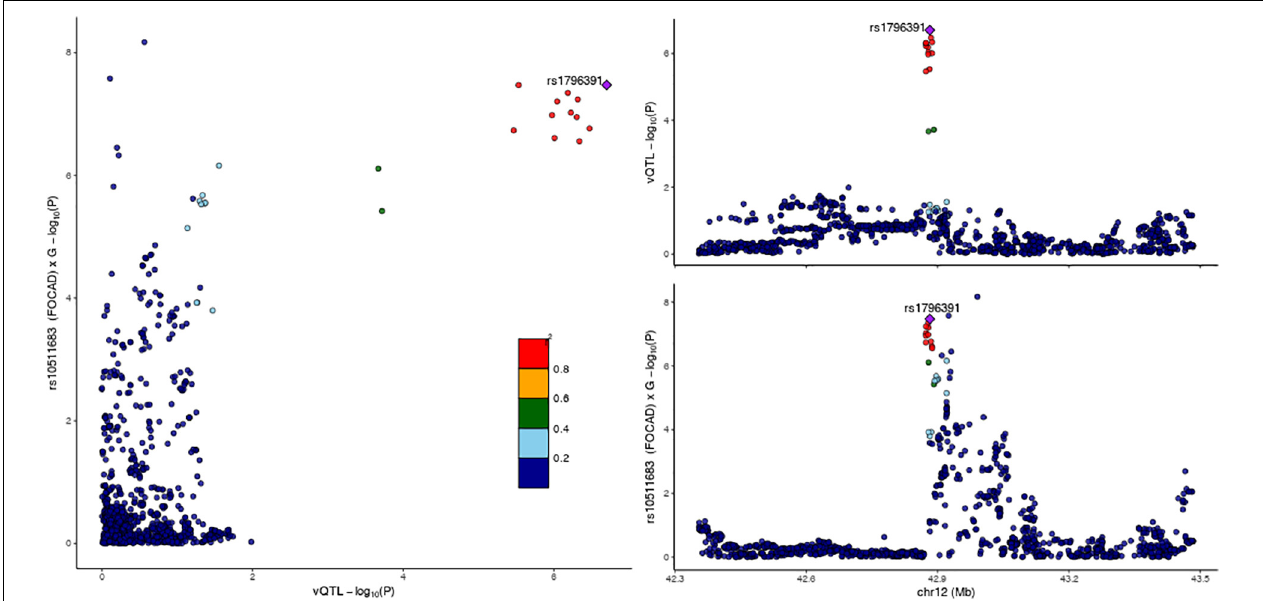
FIGURE 4 | LocusCompare plot at the PRICKLE1 locus for cranial base width. (Left) Joint distribution of the –log 10 ( p -value) from the Levene’s test and the gene-by-gene (G × G) interaction test, colored by linkage disequilibrium (LD) with rs1796391. Co-localization of the signals is supported by the clustering of dots at top right . (Top right) –log10( p -value) from the Levene’s test on the y -axis and genomic coordinate on the x -axis. (Bottom right) -log 10 ( p -value) from the G × G interaction test between rs10511683 ( FOCAD ) and SNPs at the PRICKLE1 locus on the y -axis.